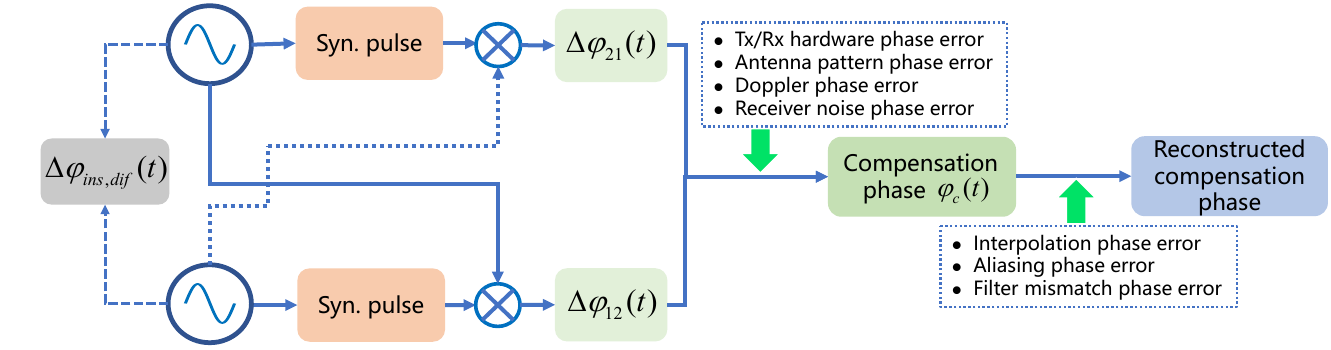
Figure 1. The error in phase